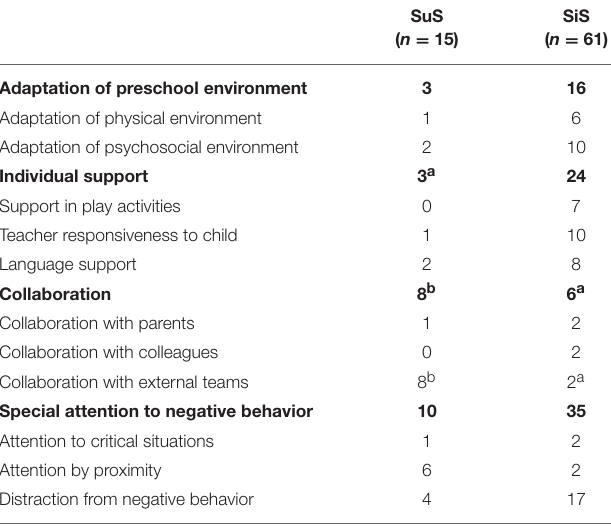
TABLE 8 | Support content for each support format (major categories in